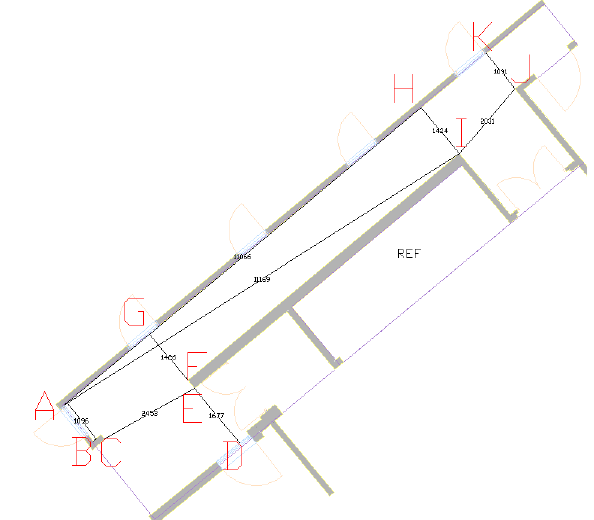
Figure 12. Plan view of reference data and placement of common measurements taken for all datasets